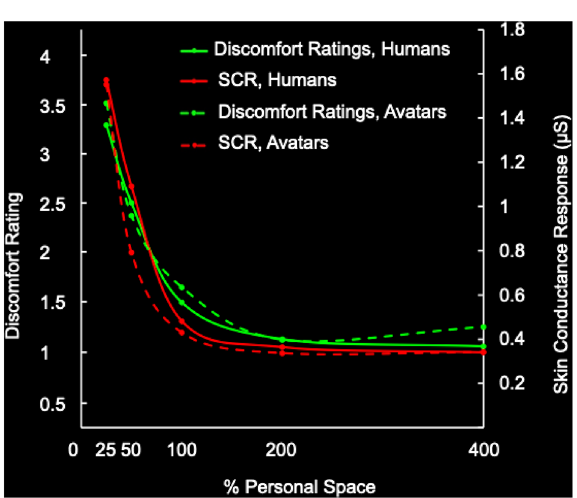
Figure 8. Model fitting of skin conductance responses. SCR peak responses (y axis) as a function of personal space size (in %, on the x axis) in response to either a human (left panel) or avatar (right panel) intruder. As in the ratings data, the averaged SCR response (dotted white line) was best fit by a power law (red), compared to either an exponential (blue) or a logarithmic (green) function.